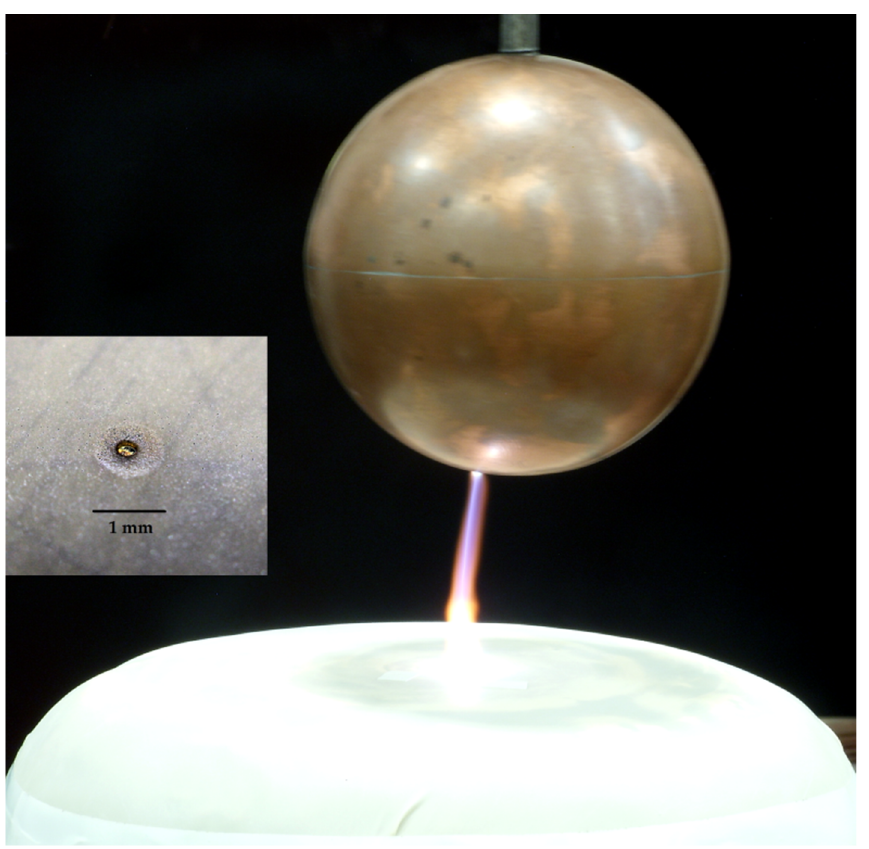
Figure 4. The simulated lightning strike over a balloon latex surface (8 s exposure) and a hole burned through the latex by the lightning’s leader. The upper electrode moved slightly off the central axis of the setup, but in this case, it had no significant impact on the flashover voltage.